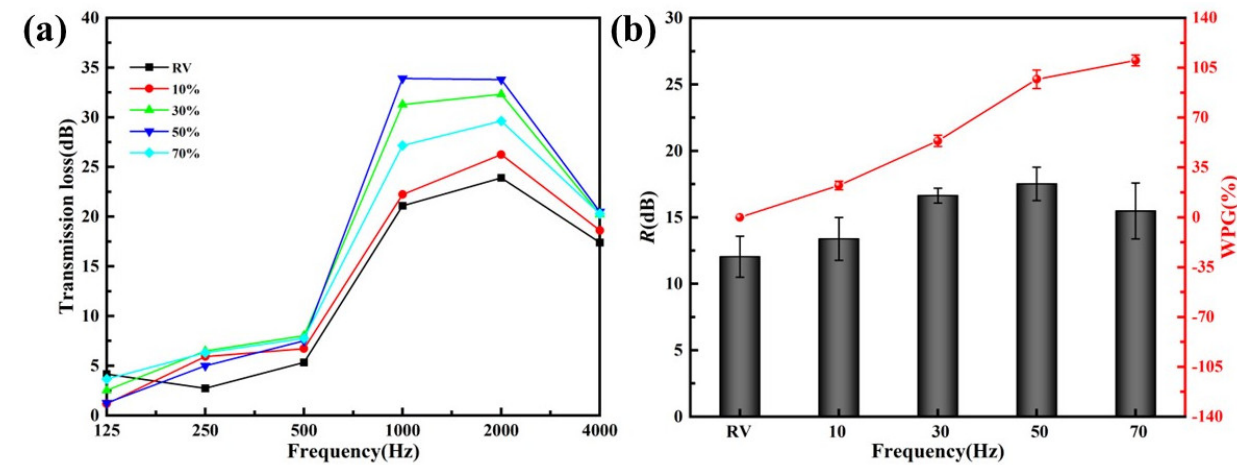
Figure 3. Sound insulation of unmodified veneer and FA-modified veneer with different FA concentrations ( a ) transmission loss dependent on the frequency; ( b ) average sound insulation and WPG.